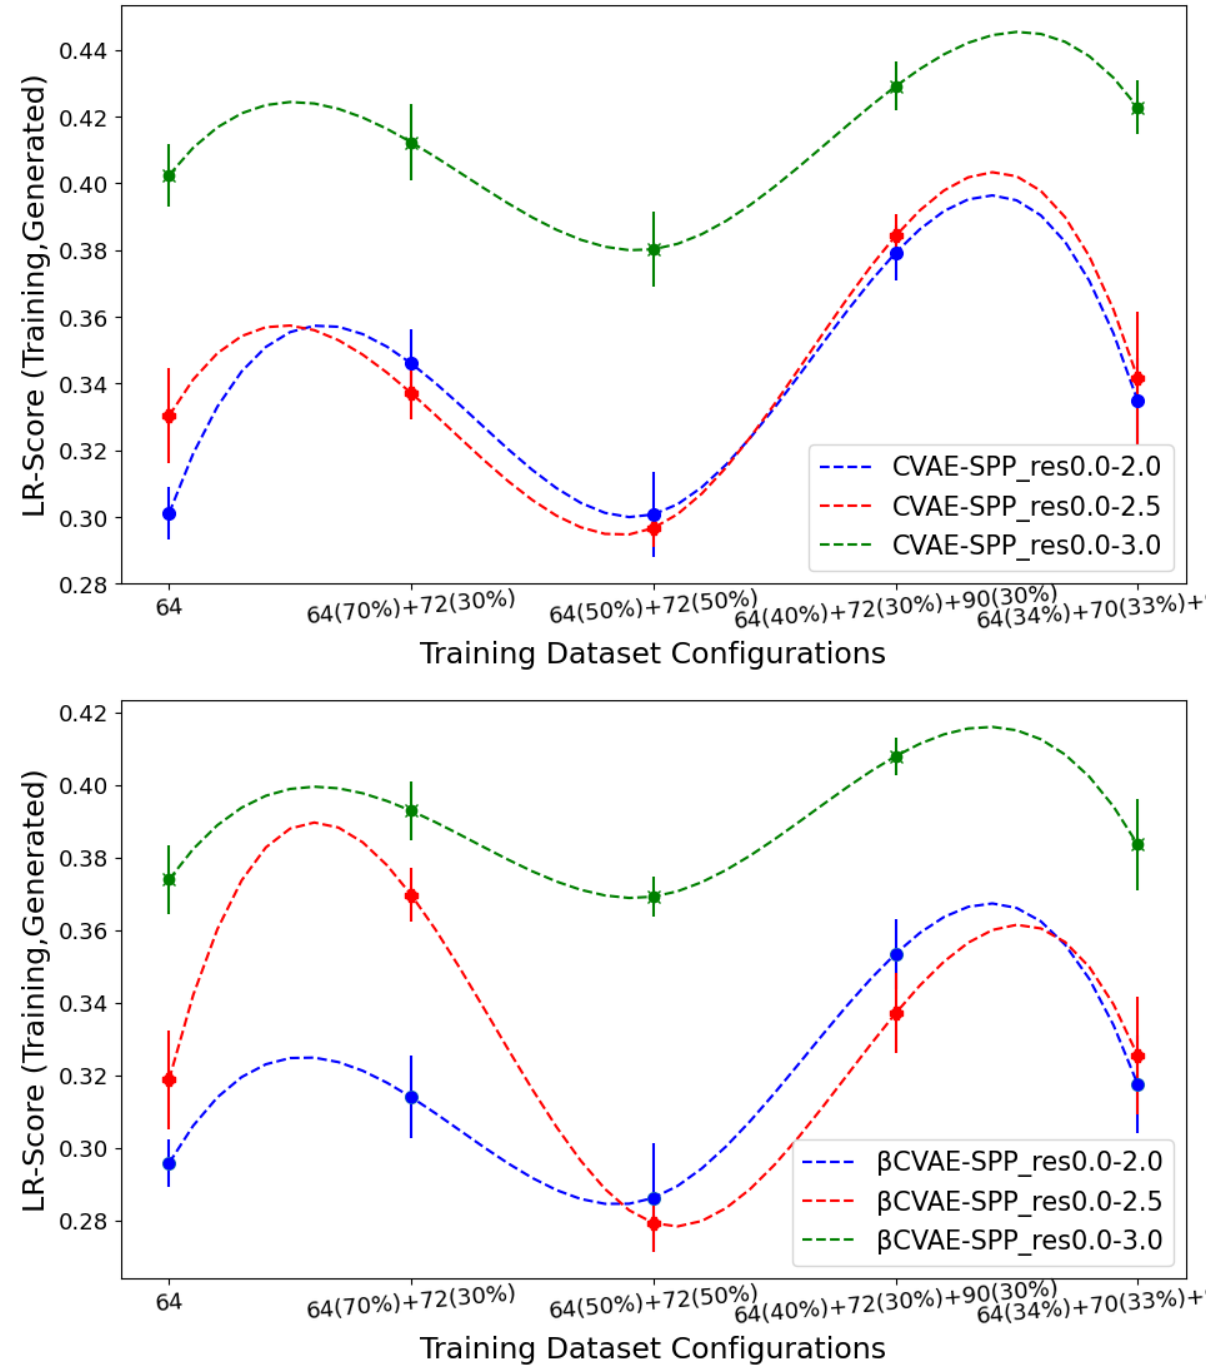
Figure 8. The EMD over LR-Score distributions of generated versus training data are tracked sepa- rately for CVAE-SPP (top panel) and β CVAE-SPP. In each panel, the comparison is made along the five training dataset configurations for each of the three input